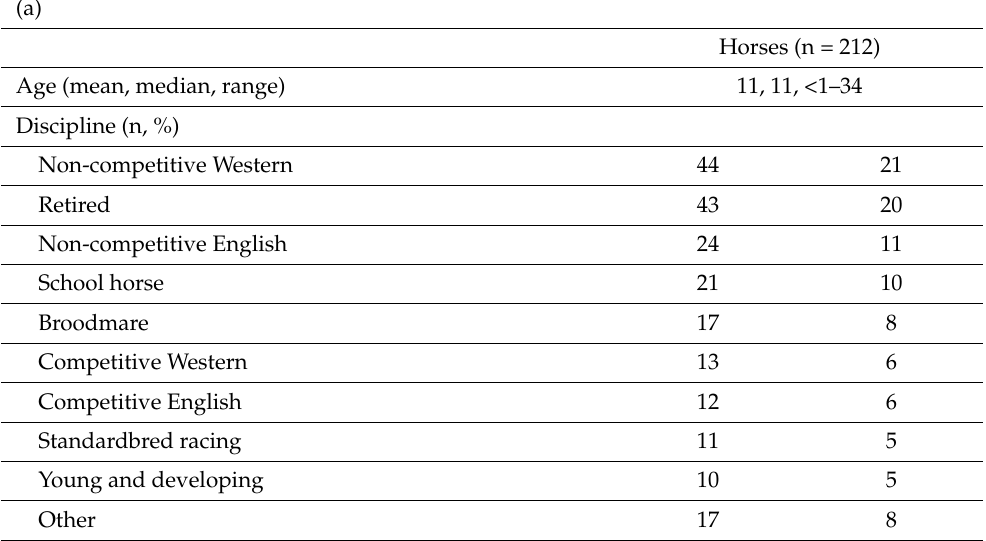
Table 1. (a). Demographics of the horses (n = 212) in Prince Edward Island that were included in the study and owned by one of the owners in (b). Demographics of the horse owners (n = 76) in Prince Edward Island who participated in the